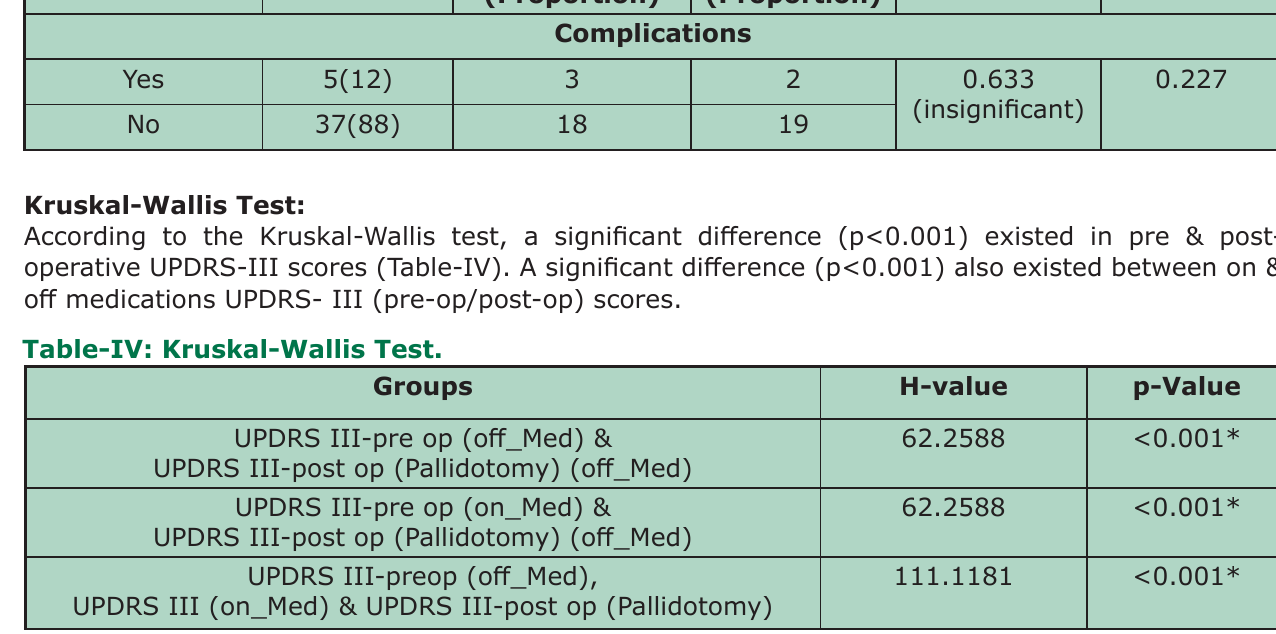
Table-III: Stratification of Left/Right Side Proportions Symptoms and Complication